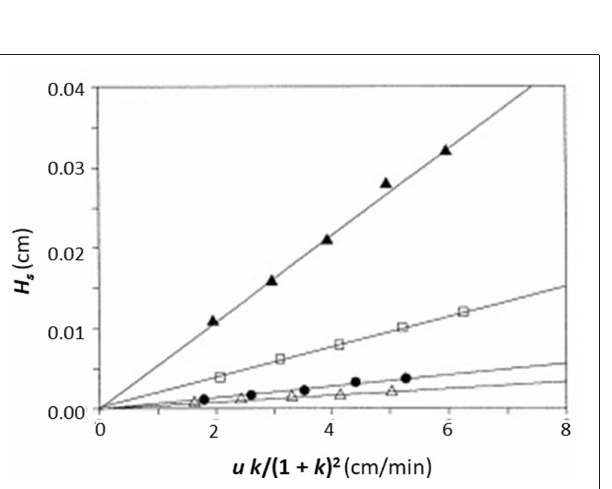
k ) 2 , as obtained by the plate height FIGURE 3 | Plot of H s vs. ( uk )/(1 + method, to analyze the binding of D-tryptophan with an HPAC column containing immobilized HSA. These data were obtained at 25 ◦ C and at mobile phase pH values of 4.0 ( 1 ), 5.0 (•), 6.0 ( (cid:3) ), or 7.0 ( N ). Reproduced with permission from Yang and Hage (1997). Copyright 1997